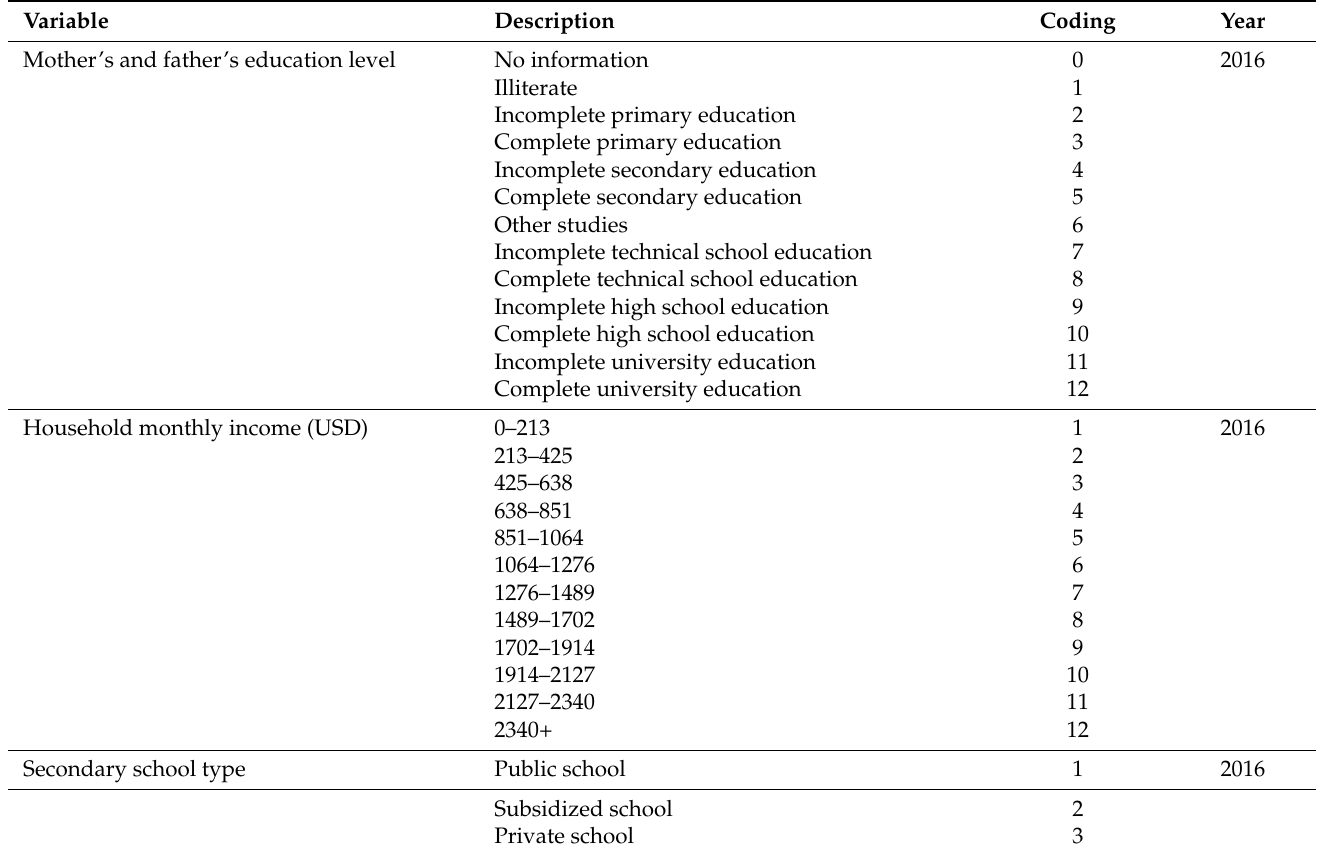
Table A1. Coding of indicators of the latent variable social capital.